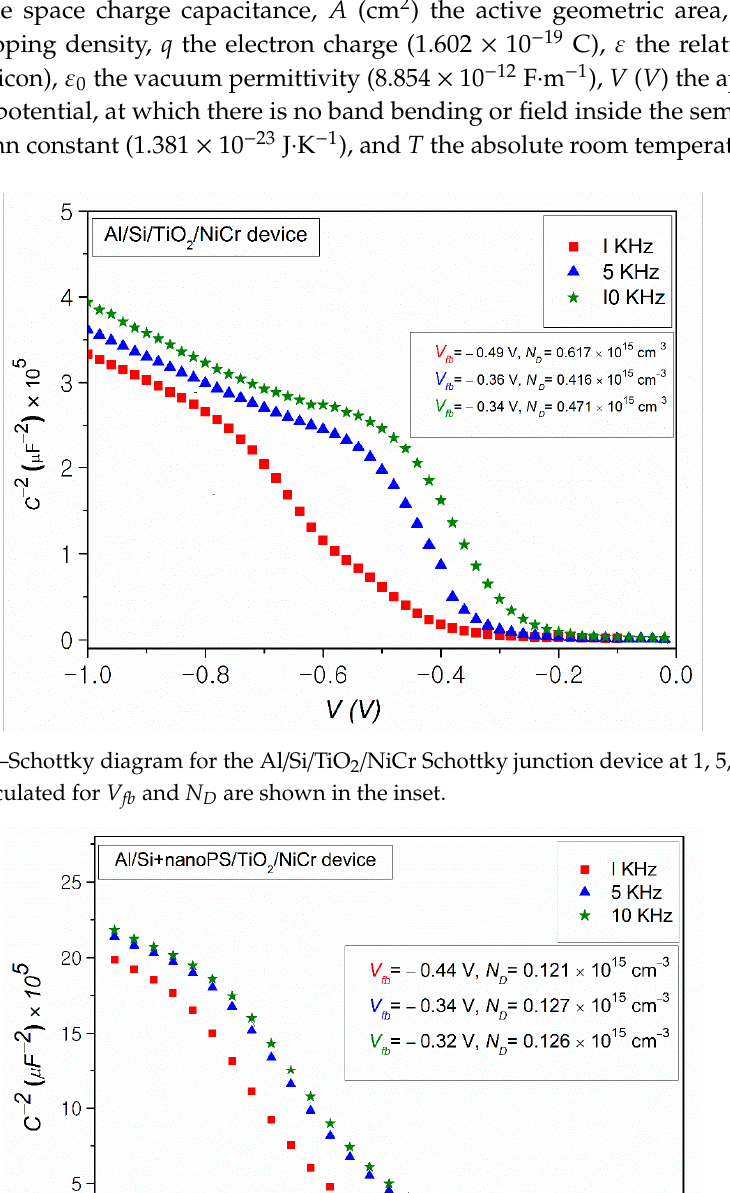
Figure 5. Bode diagram to study the effect of frequency on the total impedance for the three MIS Schottky barrier devices analyzed.